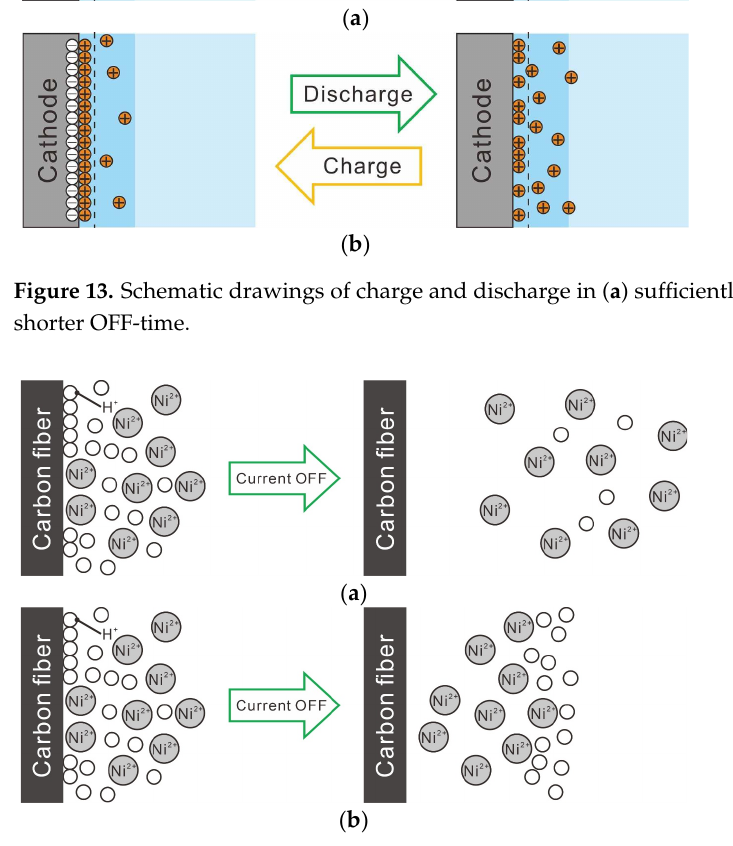
Figure 14. Schematic drawings of diffusion distance of cations in ( a ) sufficiently longer OFF-time and ( b ) shorter OFF-time.